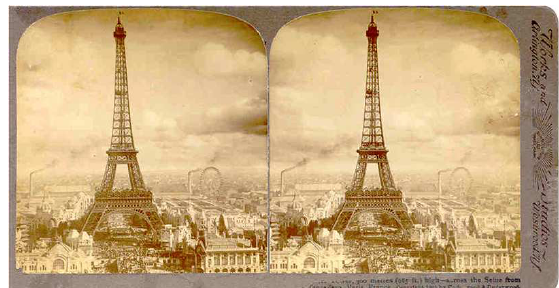
Figure 4. Outstanding historic 3D photograph of the Eiffel